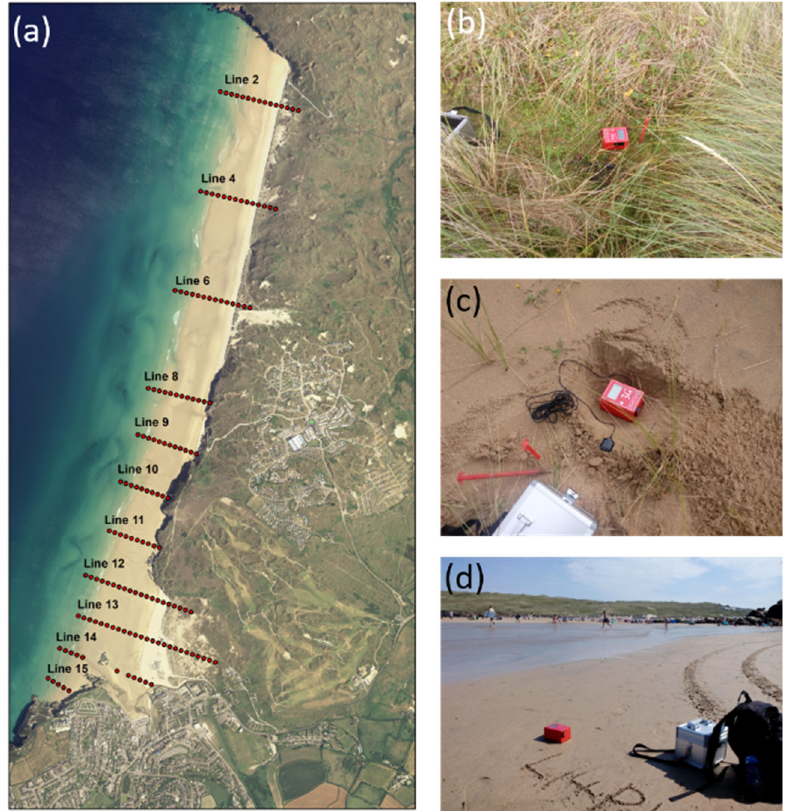
Figure 3. ( a ) Location of the 149 stations sampled using the passive seismic survey method at Perran Beach where each station was identified by the line (L) and point (P) number (e.g., L12P1); ( b , c ) physical setup at stations located at the vegetated and non-vegetated dune; ( d ) at the intertidal beach.